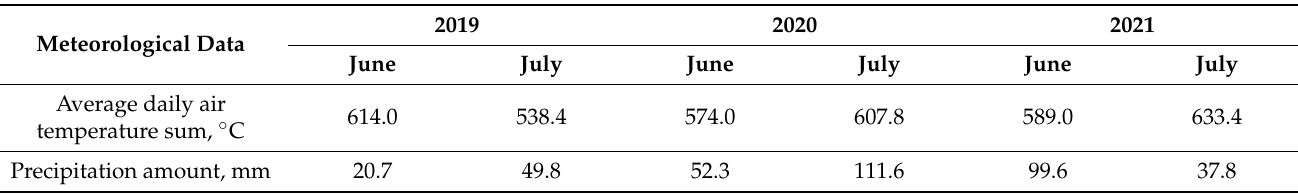
Table 2. Meteorological data in summer